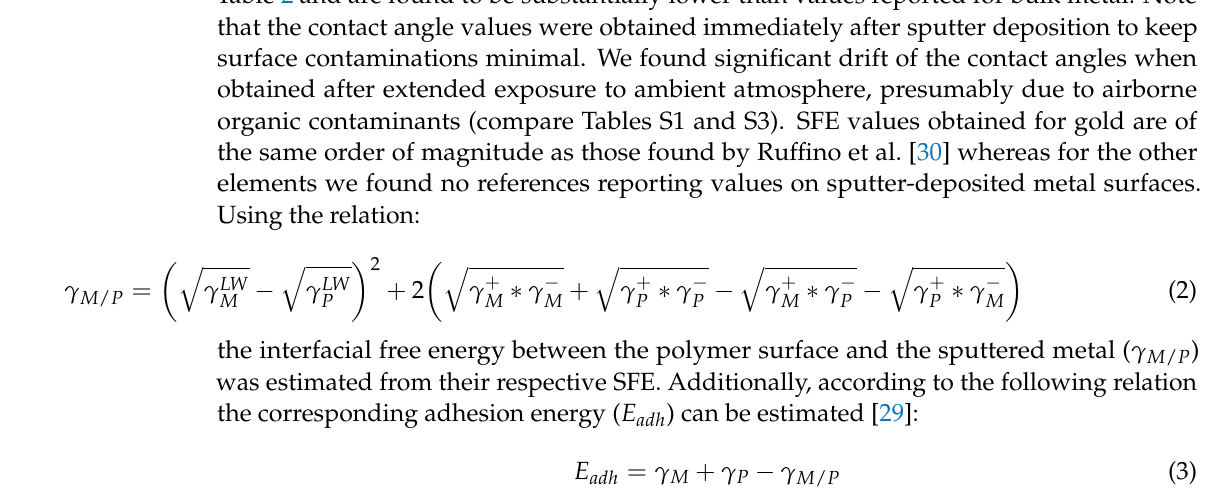
Table 2. Estimated surface free energy components, interfacial energy ( γ M/P ) and adhesion energy ( E adh ) for the polymer surface and the respective metal reported as average and standard deviation.